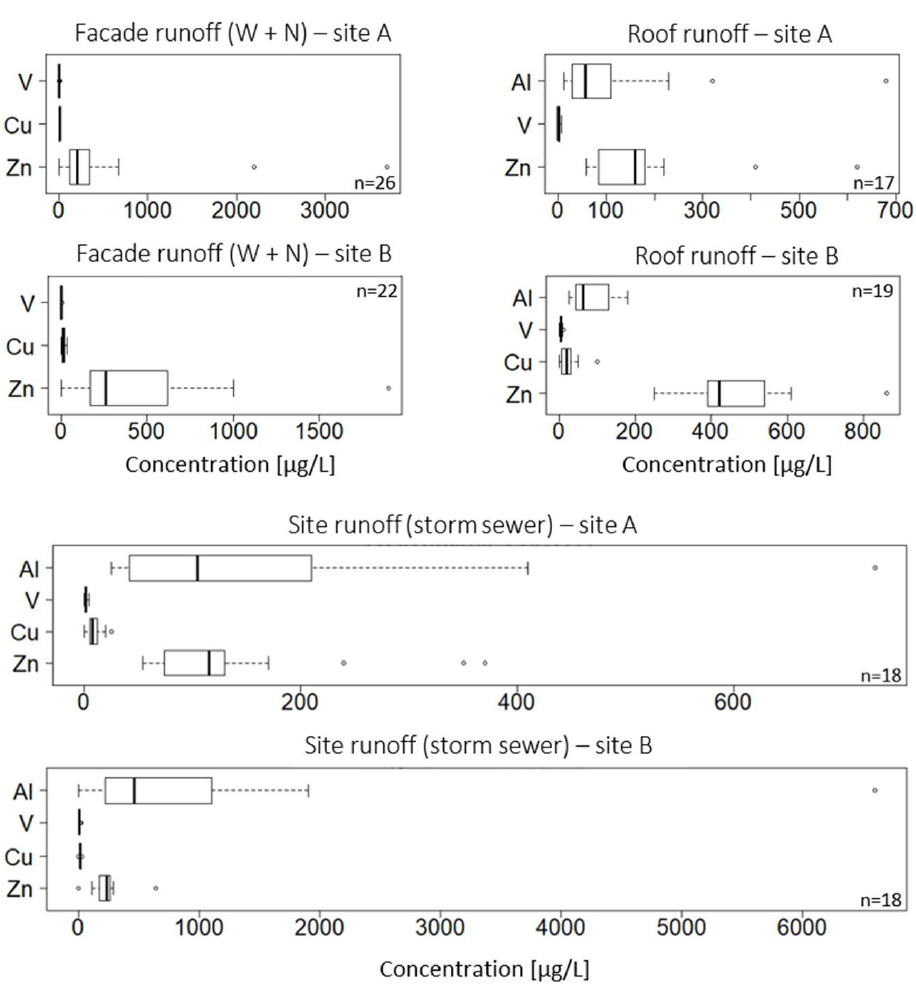
Figure 5. Concentrations of heavy metals in runoff of façades and roofs and in site runoff of site A and site B.